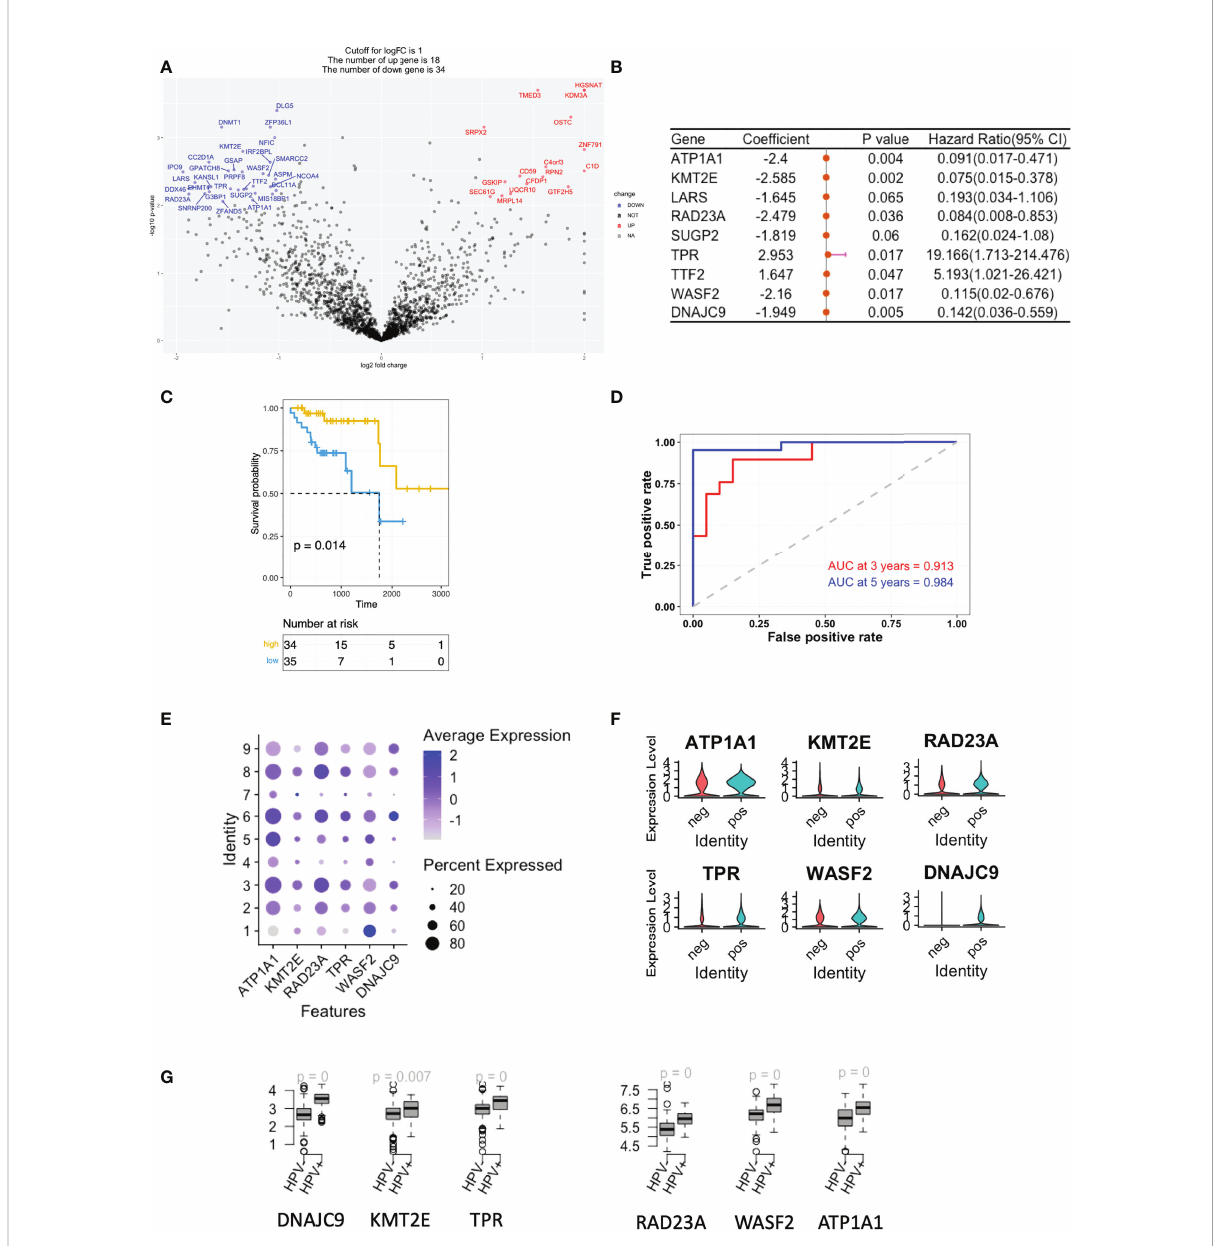
FIGURE 3 A gene signature based on the scoring of the level of stemness. (A) A volcano plot showing the stemness-related genes obtained from Cox regression analysis of survival-related HPV + HNSCC patients. (B) Forest plot lines of the stemness-related top genes screened by using random survival forest analysis of HPV + HNSCC patients. (C) Kaplan-Meier analysis of the risk groups that were de fi ned with six gene tags associated with cell stemness in the TCGA dataset for HPV + HNSCC. (D) Three- and fi ve-year ROC survival curves of the risk groups from the TCGA dataset for HPV + HNSCC. (E) Dot plots indicating the expression of the six signature genes in the nine states that were identi fi ed by trajectory analysis of HPV + and HPV - tumour cells. (F) Violin plots indicating the expression of the six signature genes in the HPV + and HPV - tumour cells. (G) Boxplots showing the the expression levels of the signature genes in the TCGA HPV + and HPV - patients. p=0 refers to